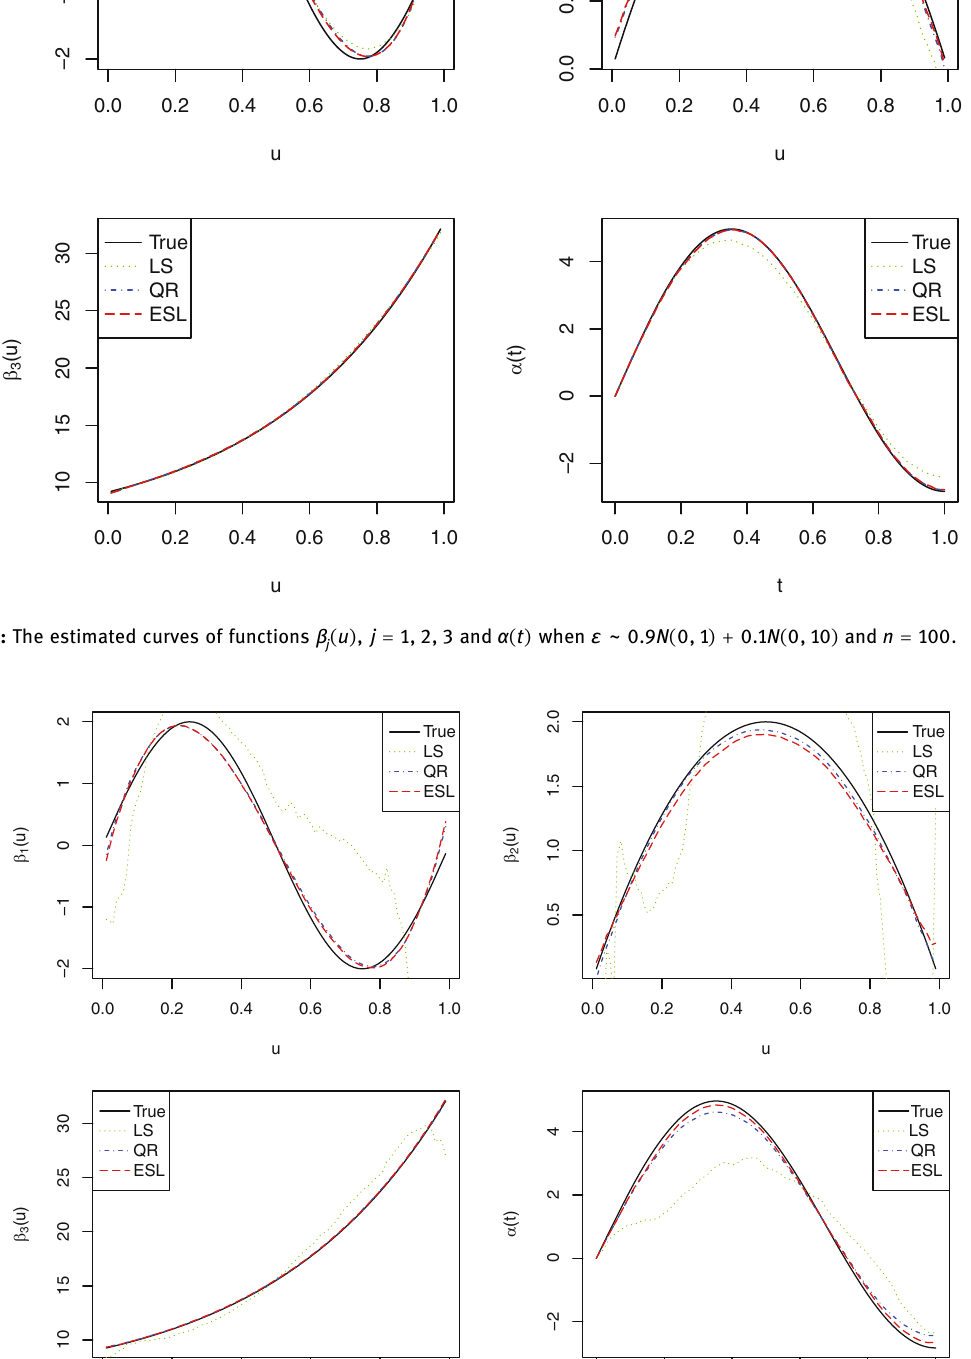
Figure 2: The estimated curves of functions ( ) β u